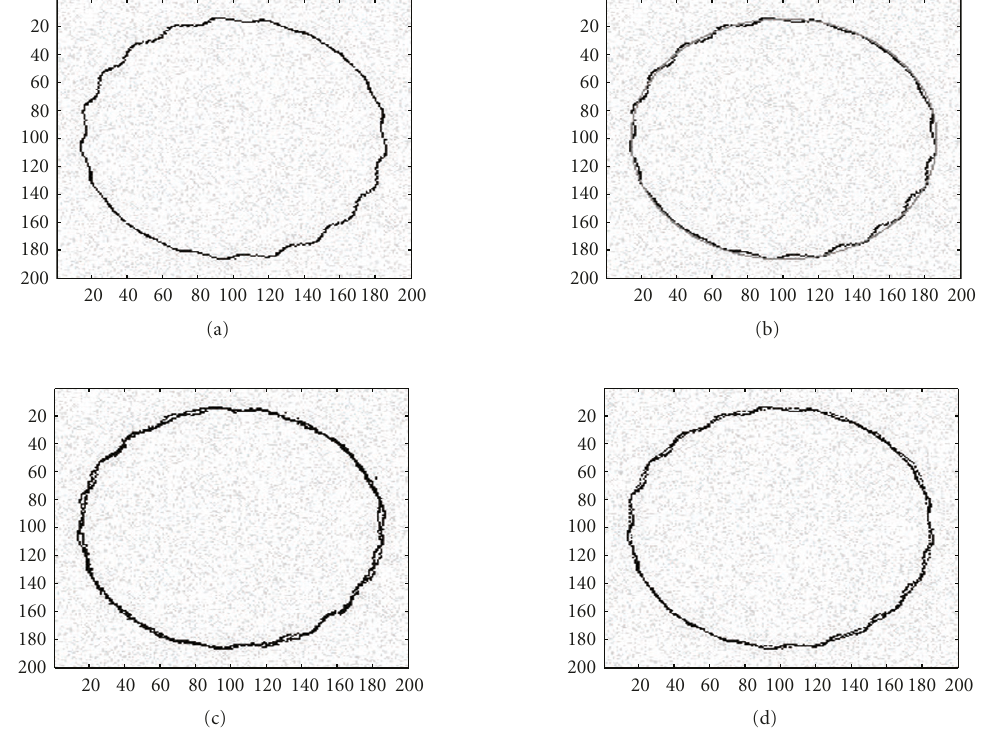
Figure 10: (a) Processed. (b) Initialization by the existing method for center estimation [6] and the proposed method for radius estimation. (c) Superposition processed and result obtained after applying gradient method: ME ρ = 0 . 55 pixel. (d) Superposition processed and result obtained after applying GVF method [8]: ME ρ = 0 . 75 pixel.